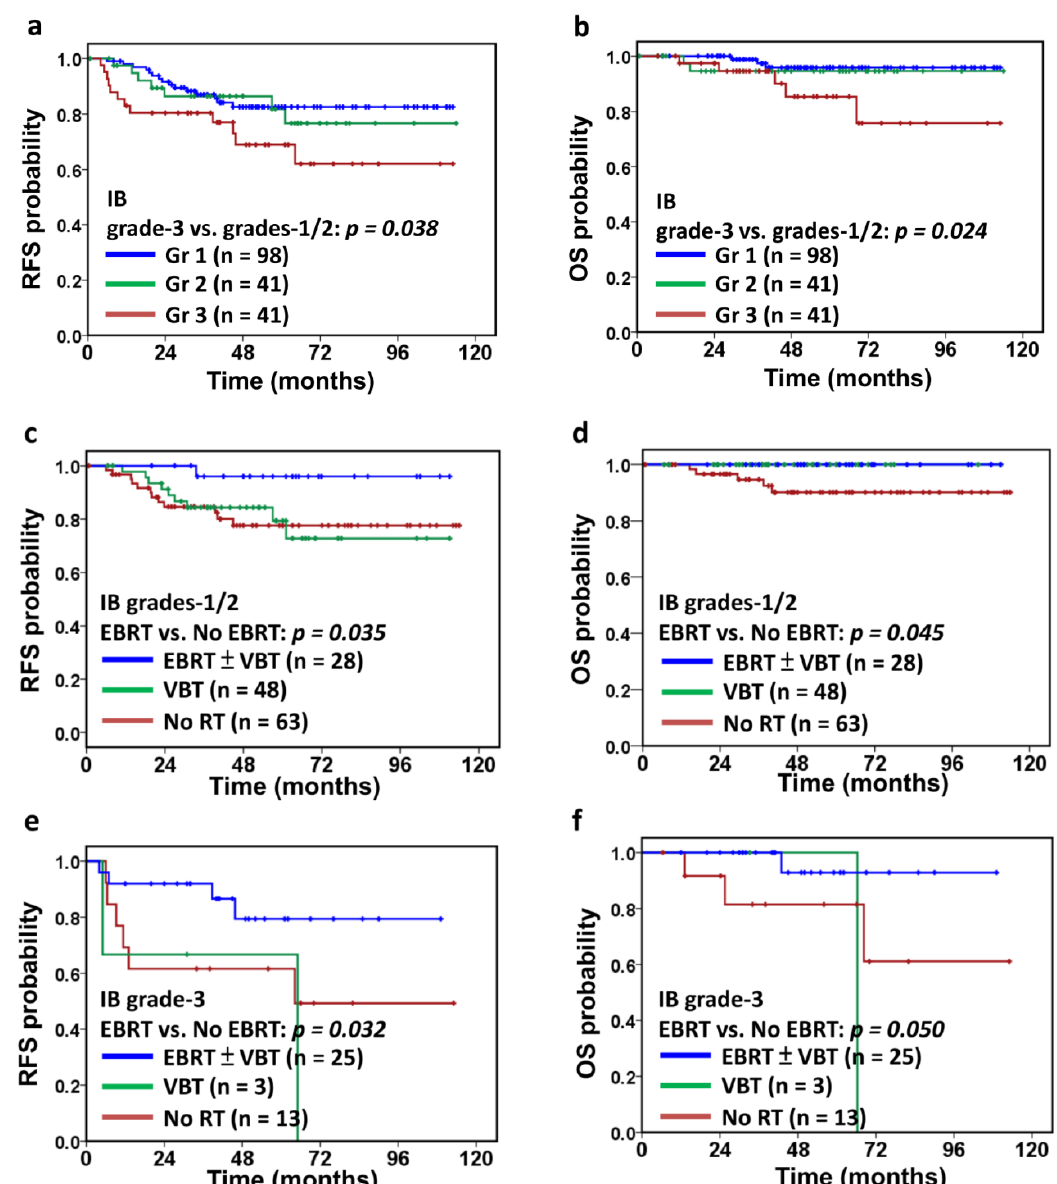
Figure 2. Survival in patients with stage IB endometrial cancer by pathology grade and by type of adjuvant radiotherapy. Recurrence-free survival (RFS) ( a ) and overall survival (OS) ( b ) of patients with stage IB endometrial cancer based on the pathology grade. Recurrence-free survival (RFS) ( c ) and overall survival (OS) ( d ) of stage IB grades-1/2 patients according to adjuvant radiotherapy: external beam radiotherapy (EBRT) ± vaginal brachytherapy (VBT) boost, VBT alone, or no radiotherapy. RFS ( e ) and OS ( f ) of stage IB grade-3 patients according to adjuvant radiotherapy. p -values were determined using the Kaplan–Meier log-rank test.